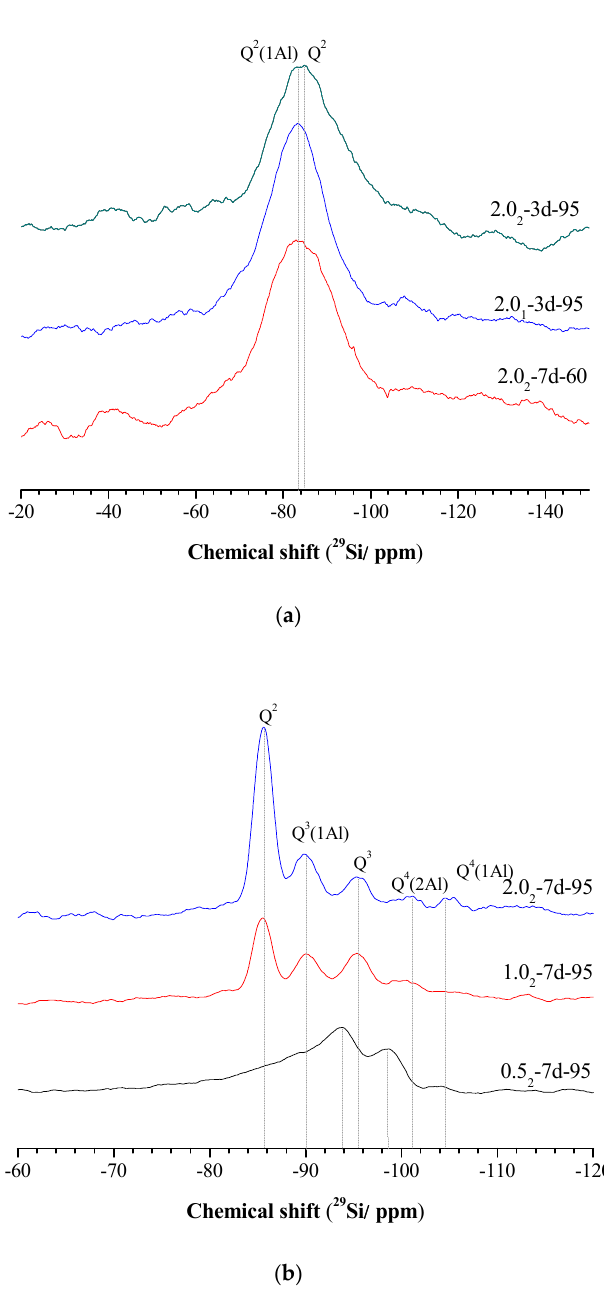
Figure 5. 29 Si MAS NMR spectra of K-A-S-H samples ( a ) synthesized at different reaction temperatures and different SiO 2 /Al 2 O 3 ratios, and ( b ) synthesized using different K 2 O/SiO 2 ratios by reaction at 95 °C.